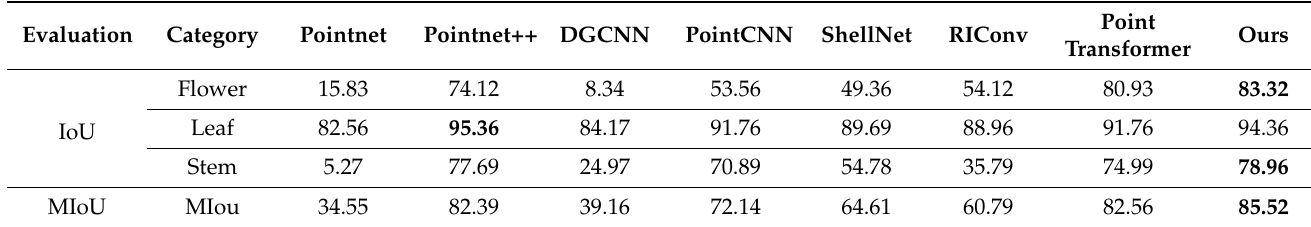
Table 1. Comparison of network segmentation effect indicators